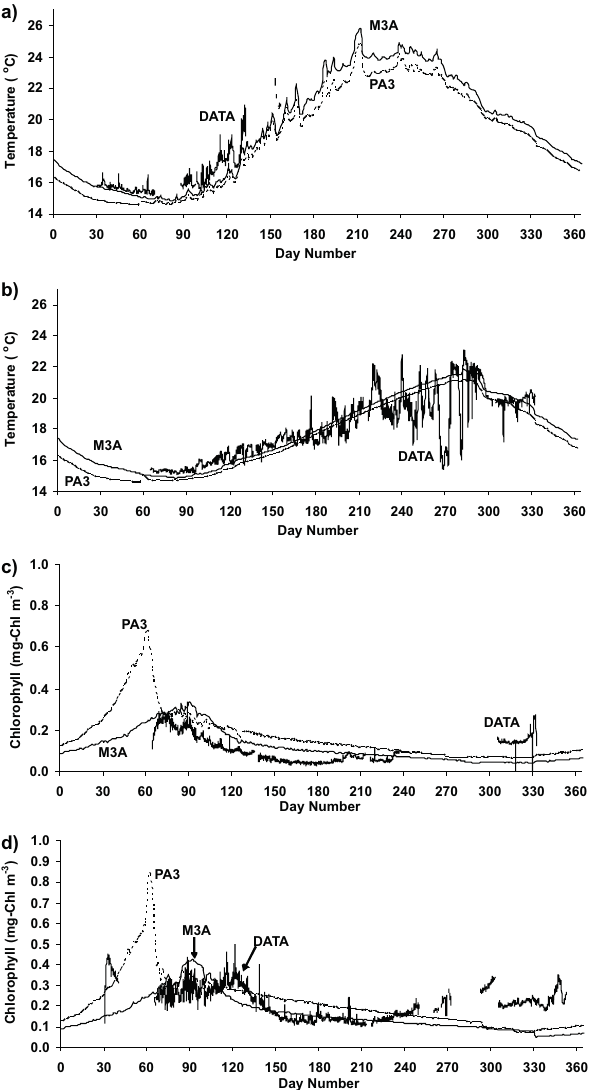
Fig. 10. Temperature at (a) the surface and (b) 40m and chlorophyll at (c) 40m and (d) 65m for the standard PA3 run (solid line) and the PA3 run with M3A derived humidity (dashed line).